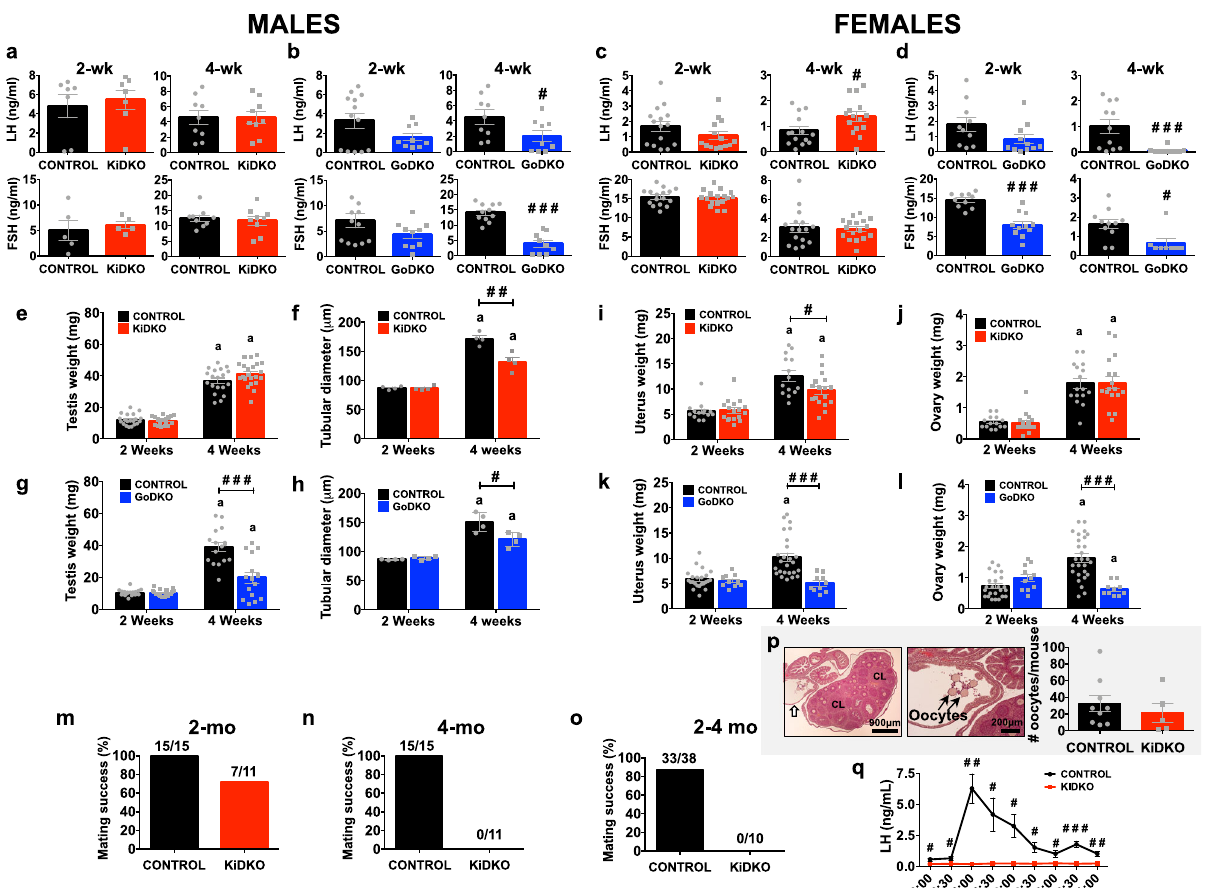
Fig. 2 | Reproductive indices in KiDKO and GoDKO mice during the infantile- pubertal transition. Data from the two models, KiDKO (Kiss1-speci fi c Dicer KO) and GoDKO (GnRH-speci fi c Dicer KO), are presented. Serum LH and FSH levels in KiDKO ( a ; LH in males: control n =7, KiDKO n =7 for 2 week and control n =9, KiDKO n =9 for 4 week; FSH in males: control n =5, KiDKO n =5 for 2 week and control n =9, KiDKO n =9 for 4 week; c ; LH in females: control n =15,KiDKO n =14 for 2 week and control n =14, KiDKO n =15 for 4 week; FSH in females: control n =16, KiDKO n =17 for both 2 and 4 week) and GoDKO ( b ; LH in males: control n =13, GoDKO n =9 for 2 week and control n =9, GoDKO n =9 for 4 week; FSH in males: control n =12, GoDKO n =10 for 2 week and control n =11, GoDKO n =9 for 4week; d ;LHinfemales:control n =10,GoDKO n =11for2weekandcontrol n =11, GoDKO n =9for4week;FSHinfemales:control n =10,GoDKO n =11for2weekand control n =11,GoDKO n =8for4week)mice,at2and4weeksofage,areshown.In addition, testicular weight and tubular diameter in KiDKO males ( e ; control n =20, KiDKO n =18for2weekandcontrol n =19,KiDKO n =22for4week; f ;control n =4, KiDKO n =4forboth2and4week)andGoDKO( g ;control n =18,GoDKO n =19for 2 week and control n =16, GoDKO n =15 for 4 week; h ; control n =4, GoDKO n =4